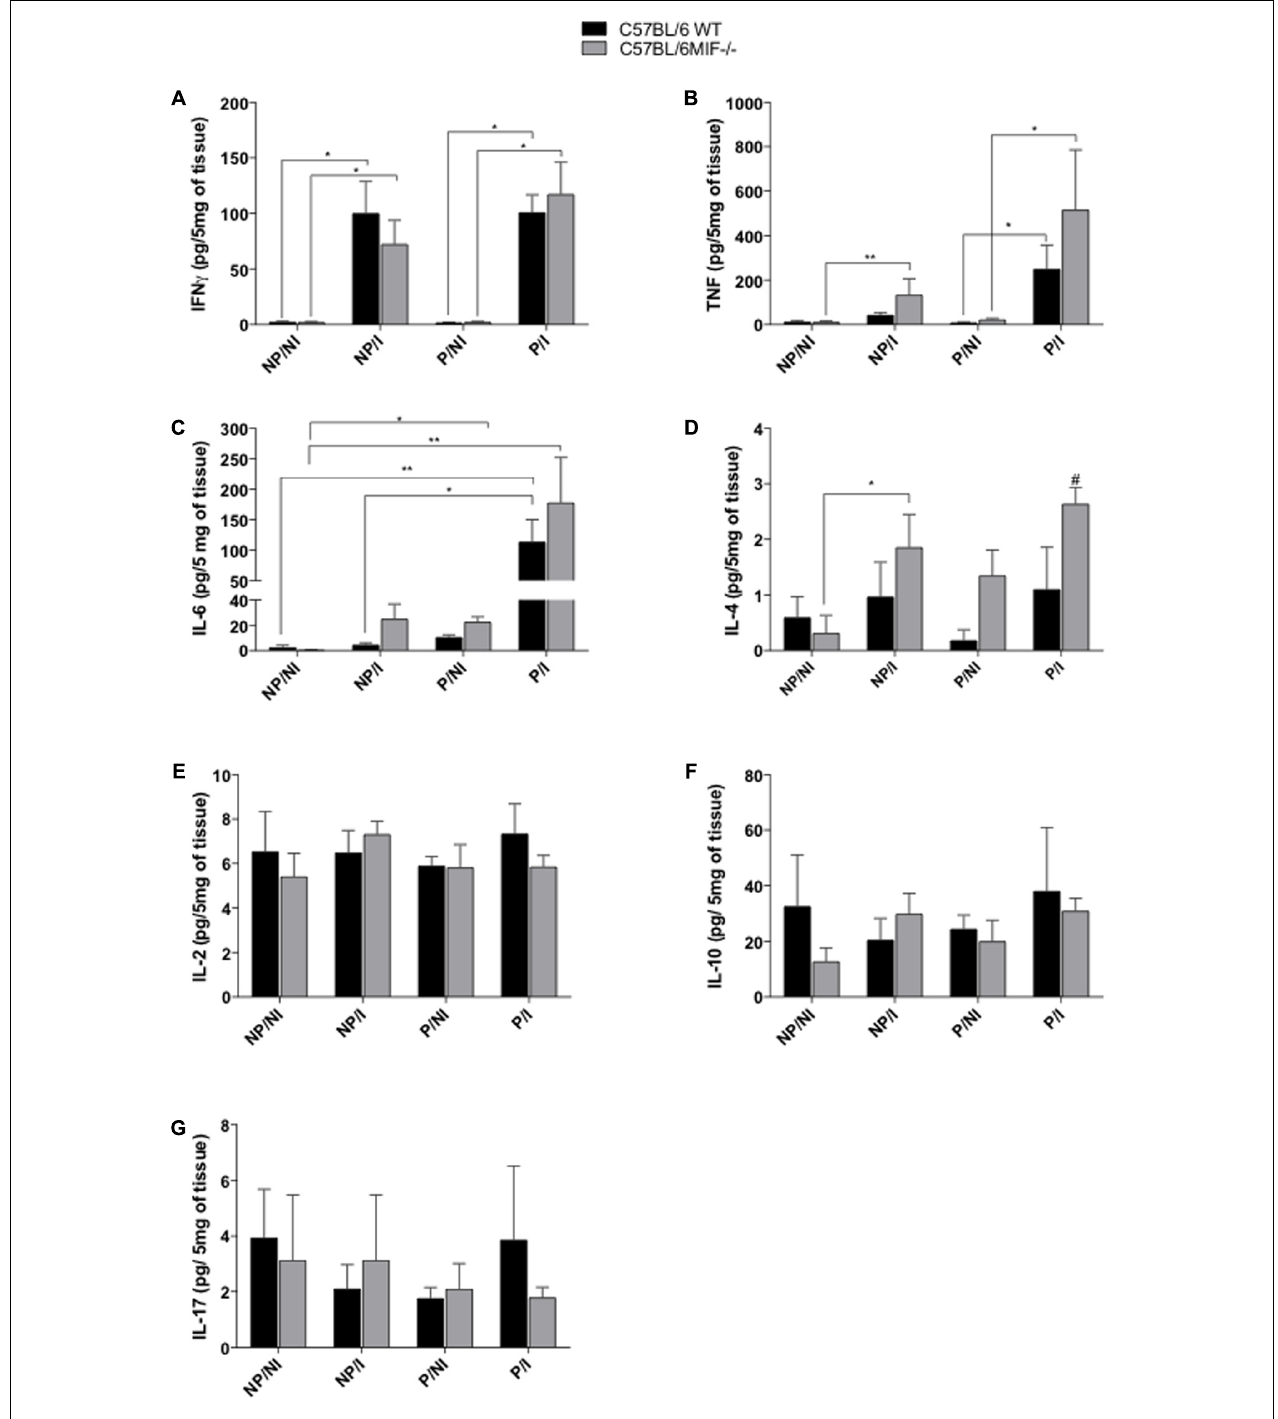
FIGURE 4 | Cytometric bead assay (CBA) for cytokine measurements in uterus tissues from pregnant and non-pregnant C57BL/6 MIF − / − and C57BL/6 WT mice orally infected with Toxoplasma gondii. Uterus tissue samples were collected within 8 days of infection/pregnancy. Uterus tissues from non-infected pregnant and non-pregnant mice were used as controls ( n = 5 animals per group). The uterus tissue homogenates were prepared in a concentration of 200 mg/mL. Data are expressed as mean and SEM of the amount of cytokines (pg) present in 5 mg of tissue (pg/5 mg of tissue). (A) IFN- γ , (B) TNF- α , (C) IL-6, (D) IL-4, (E) IL-2, (F) IL-10, and (G) IL-17. # Significant differences between MIF − / − and WT mice in the same experimental condition ( # P < 0.05). ∗ Comparisons between multiple experimental conditions within the same group (NP/NI, non-pregnant/non-infected; NP/I, non-pregnant/infected; P/NI, pregnant/non-infected; P/I, pregnant/infected) are indicated by bars ( ∗ P < 0.05; ∗∗ P < 0.01; ∗∗∗ P < 0.001). Data were compared by the Kruskal–Wallis test and Dunn’s multiple comparison post-test.